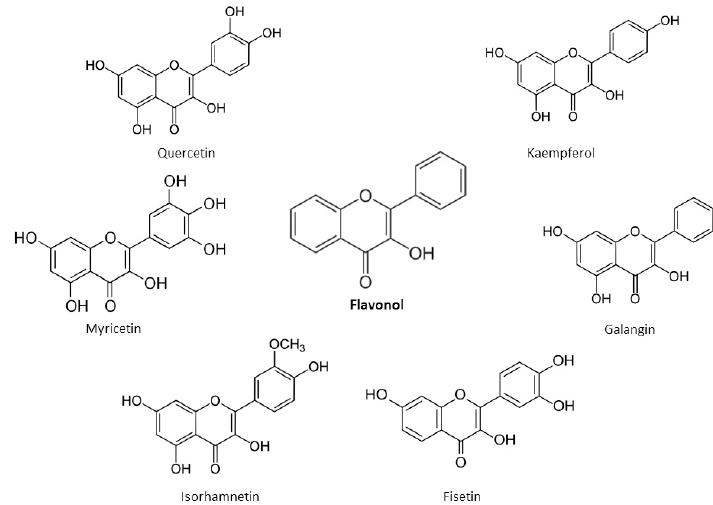
Figure 5. Chemical structures of main flavonols.